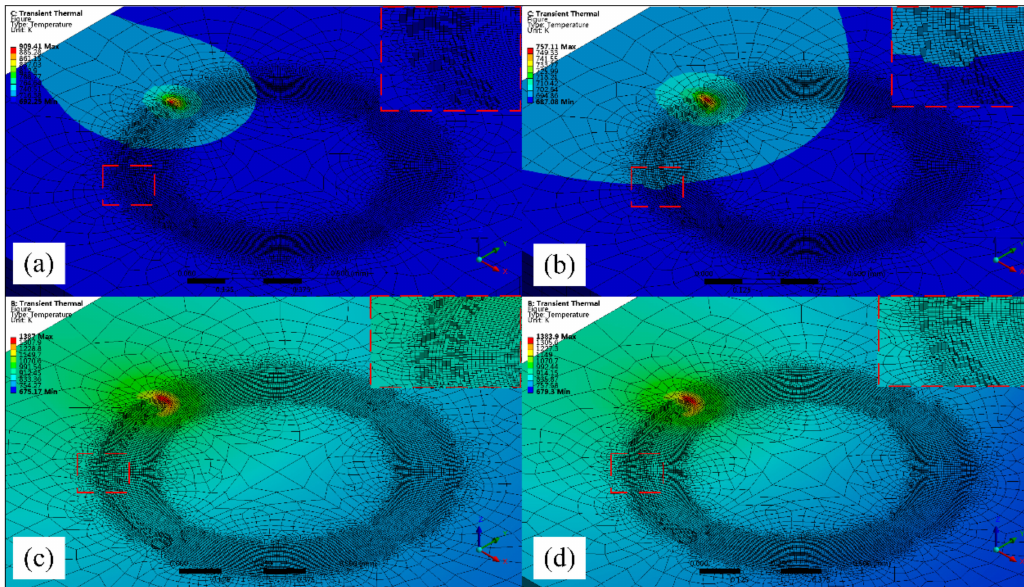
Figure 9. Helical drilling simulation of water jet-guide laser processing technology (WJGL):( a ) scanning aluminum alloy at 0.8 mm/s, ( b ) scanning aluminum alloy at 1.2 mm/s, ( c ) scanning titanium alloy at 0.8 mm/s, and ( d ) scanning titanium alloy at 1.2